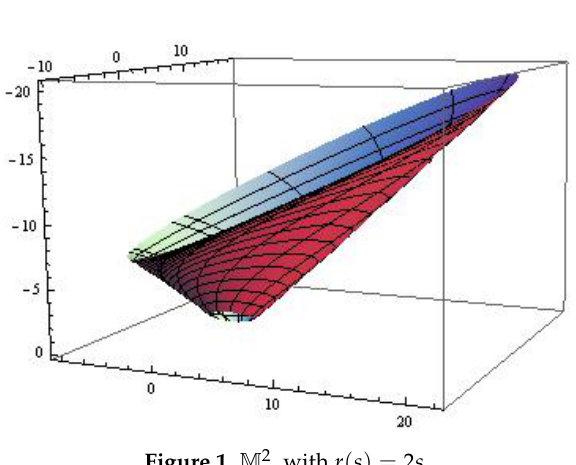
Figure 1. M 2 − with r ( s ) = 2 s